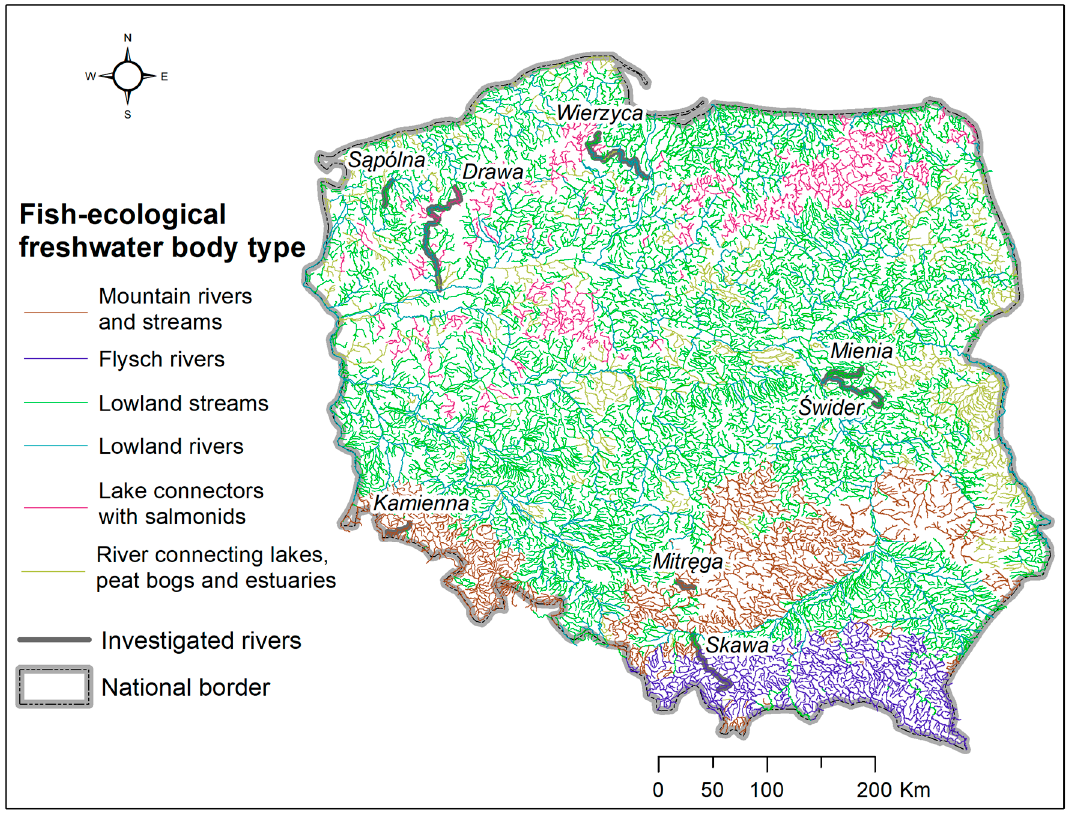
Figure 2. Map of sampling locations distribution in Poland.